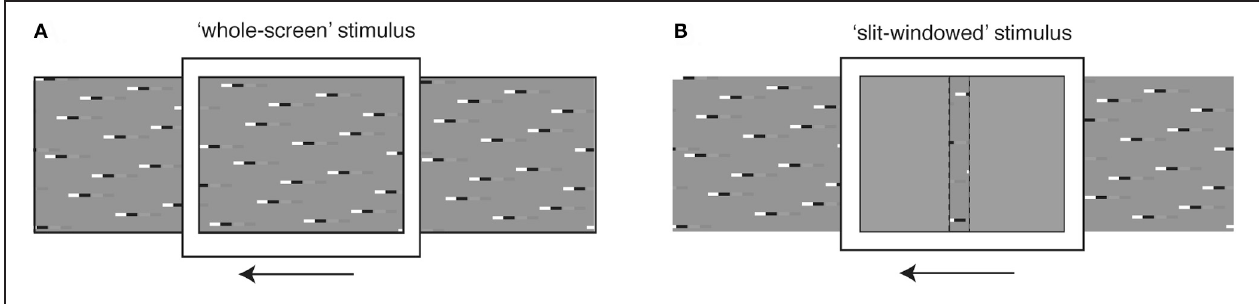
FIGURE 1 | Stimulus display modes. (A) The whole screen mode is designed to stimulate large regions of the neuron’s receptive field simultaneously, to investigate global response properties. (B) The slit windowed mode limits the stimulus width horizontally,